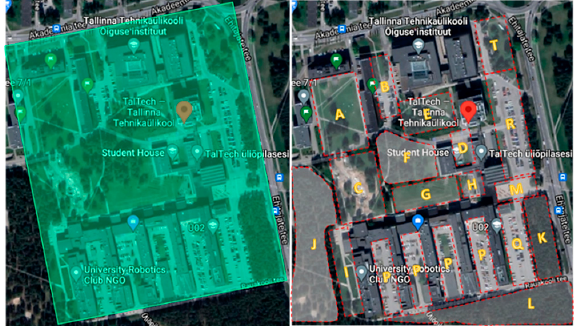
Figure 7. Taltech campus area of study according to the interview’s analyses. In the left subfigure, the green zone represents the most critical area of the campus because includes preferred areas and less attractive areas which can be improved in the future. The right subfigure shows the main area divisions referred by the interviewees [48].